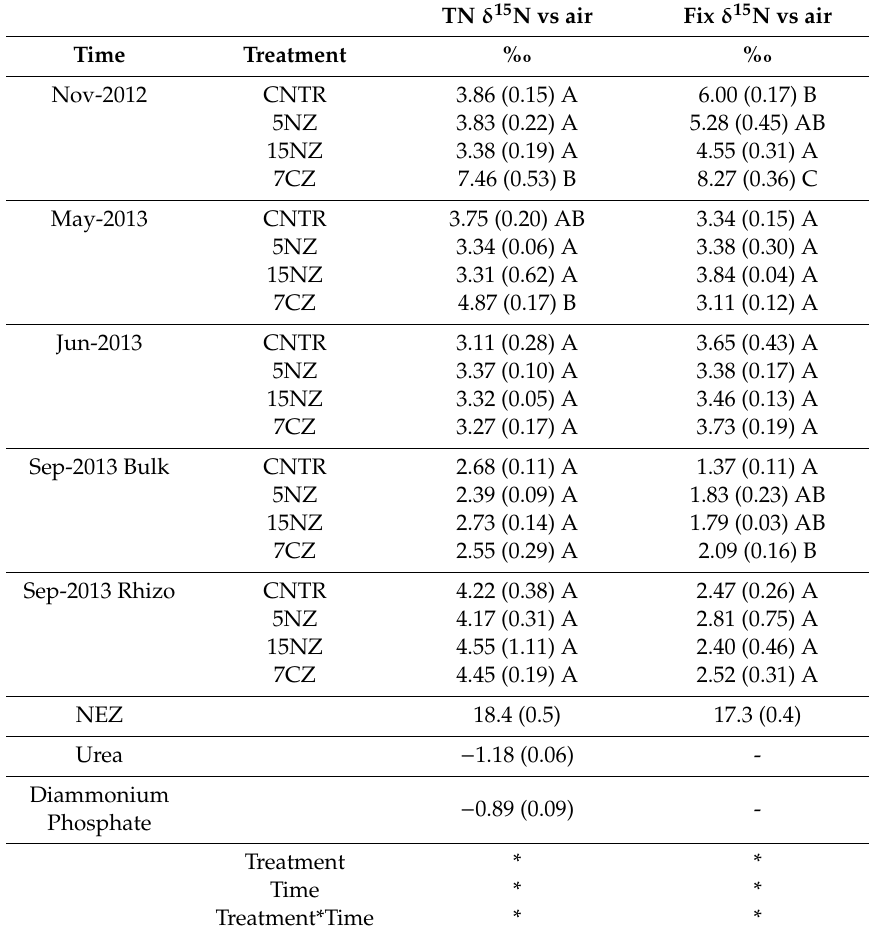
Table 4. Average 15 N natural abundance in soil N pools (TN and Fix N-NH 4 + ). Standard deviation within brackets. Significant ( p < 0.05) or non-significant ( p > 0.05) di ff erences between treatments at each sampling time are indicated by capital letters. “*” and “x” symbols indicates the presence or the absence, respectively, of a significant di ff erence among the variables for Treatments and Time in the experiment period and correlating treatments with time (Treatment*Time).